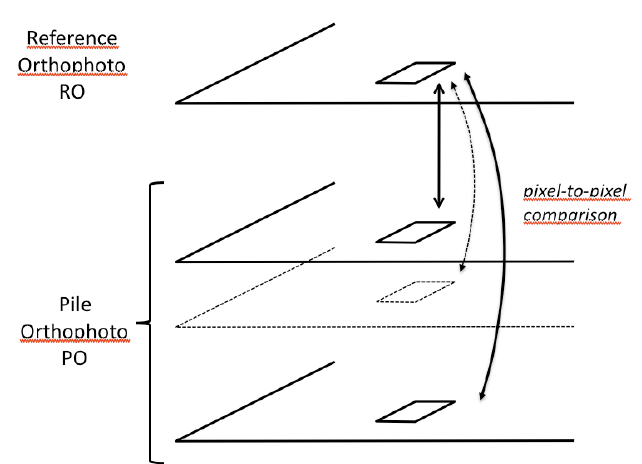
Figure 4. Seed Extraction. Illustration of the pixel-to-pixel comparison between the Reference Orthophoto RO and the other orthophotos PO contained in the pile (time series) To extract cloud seeds in one orthophoto, we proceed in the following way. Firstly, we take one orthophoto as a reference (this Reference Orthophoto RO corresponds to the